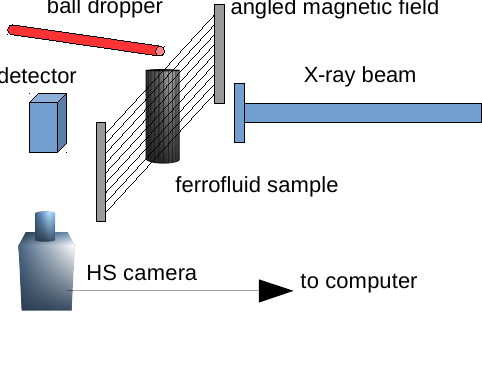
Figure 1. Schematic diagram of the